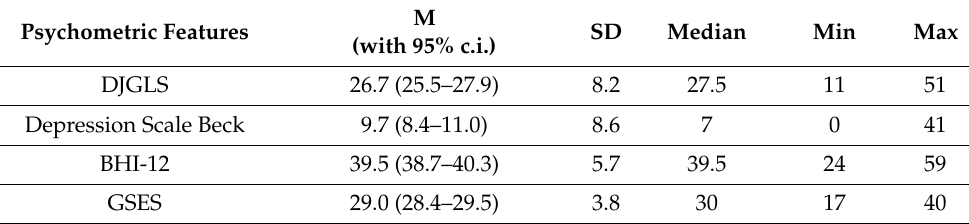
Table 2. The results of the psychometric scales of the respondents. Psychometric Features